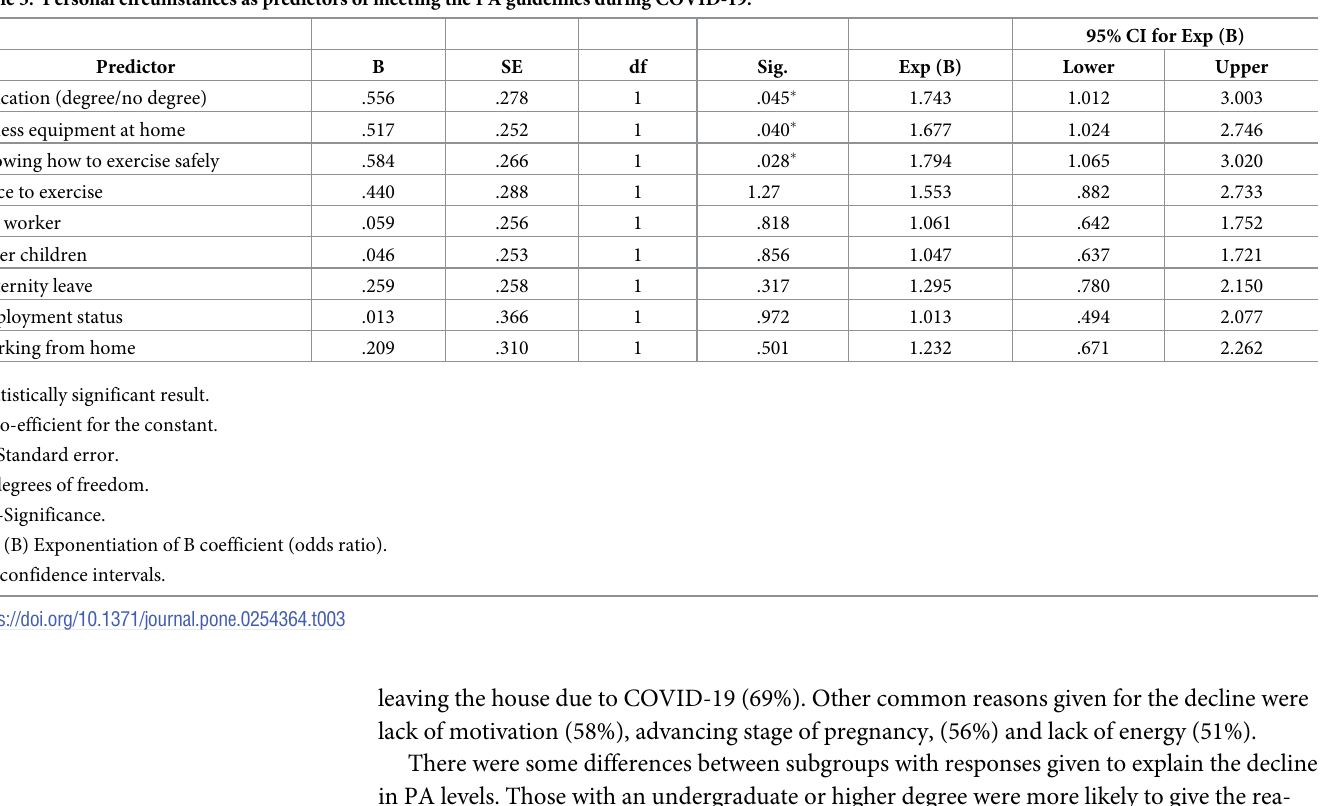
Table 3. Personal circumstances as predictors of meeting the PA guidelines during